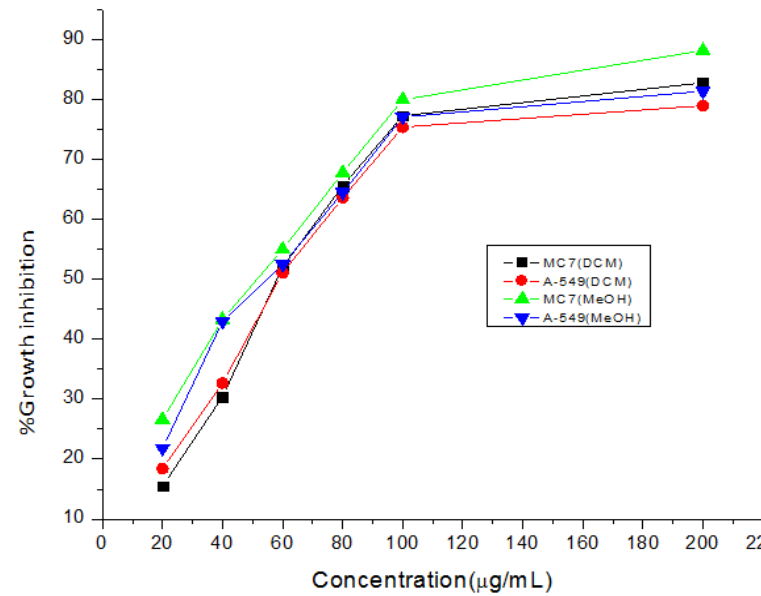
Figure 4. Anticancer activity of extracts of N.mexicana Zucc. by MTT assay.